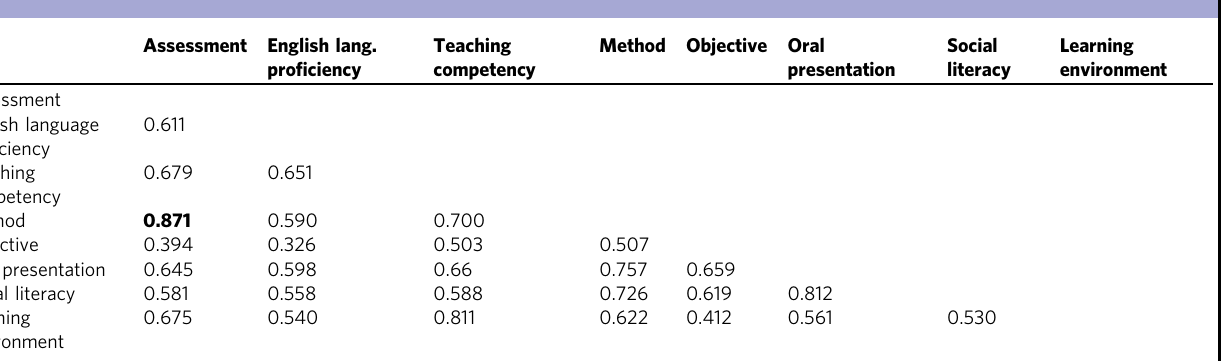
Table 6 The HTMT analysis for the initial measurement model.